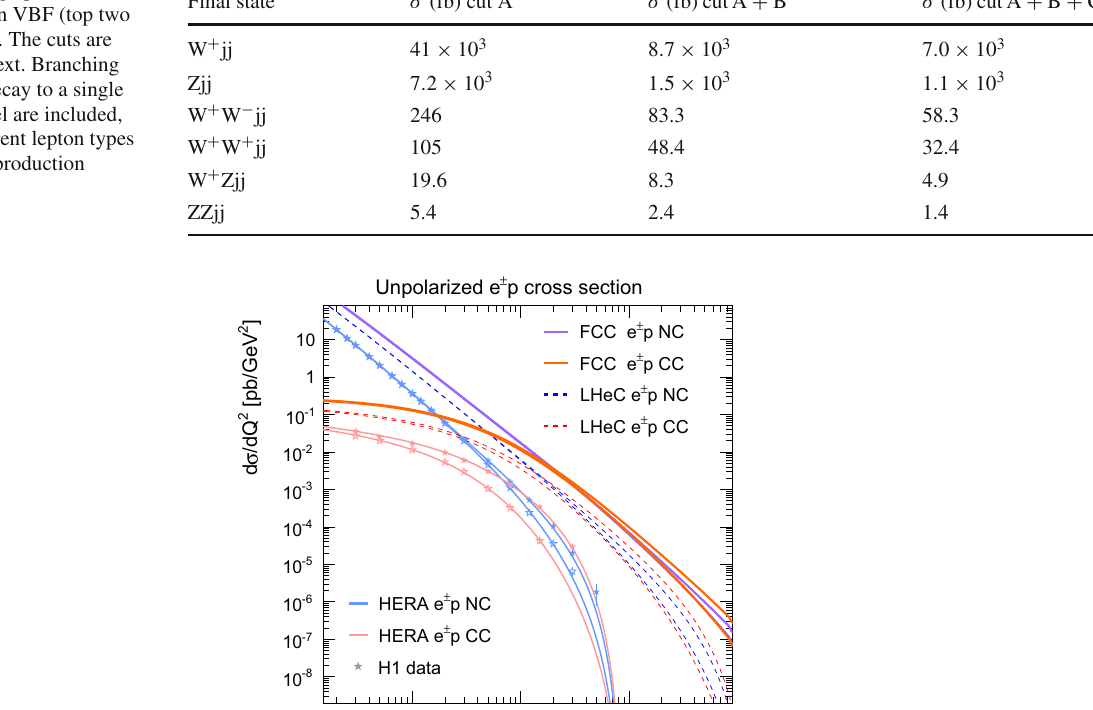
Table 3.4 Gauge production cross sections in VBF (top two lines) and VBS. The cuts are defined in the text. Branching ratios for the decay to a single leptonic channel are included, assuming different lepton types